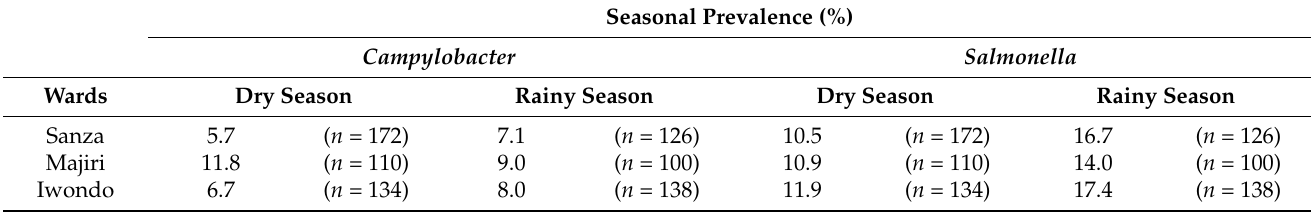
Table 3. Comparison of the prevalence of Campylobacter , Salmonella, and mixed infections, by ward and by season.